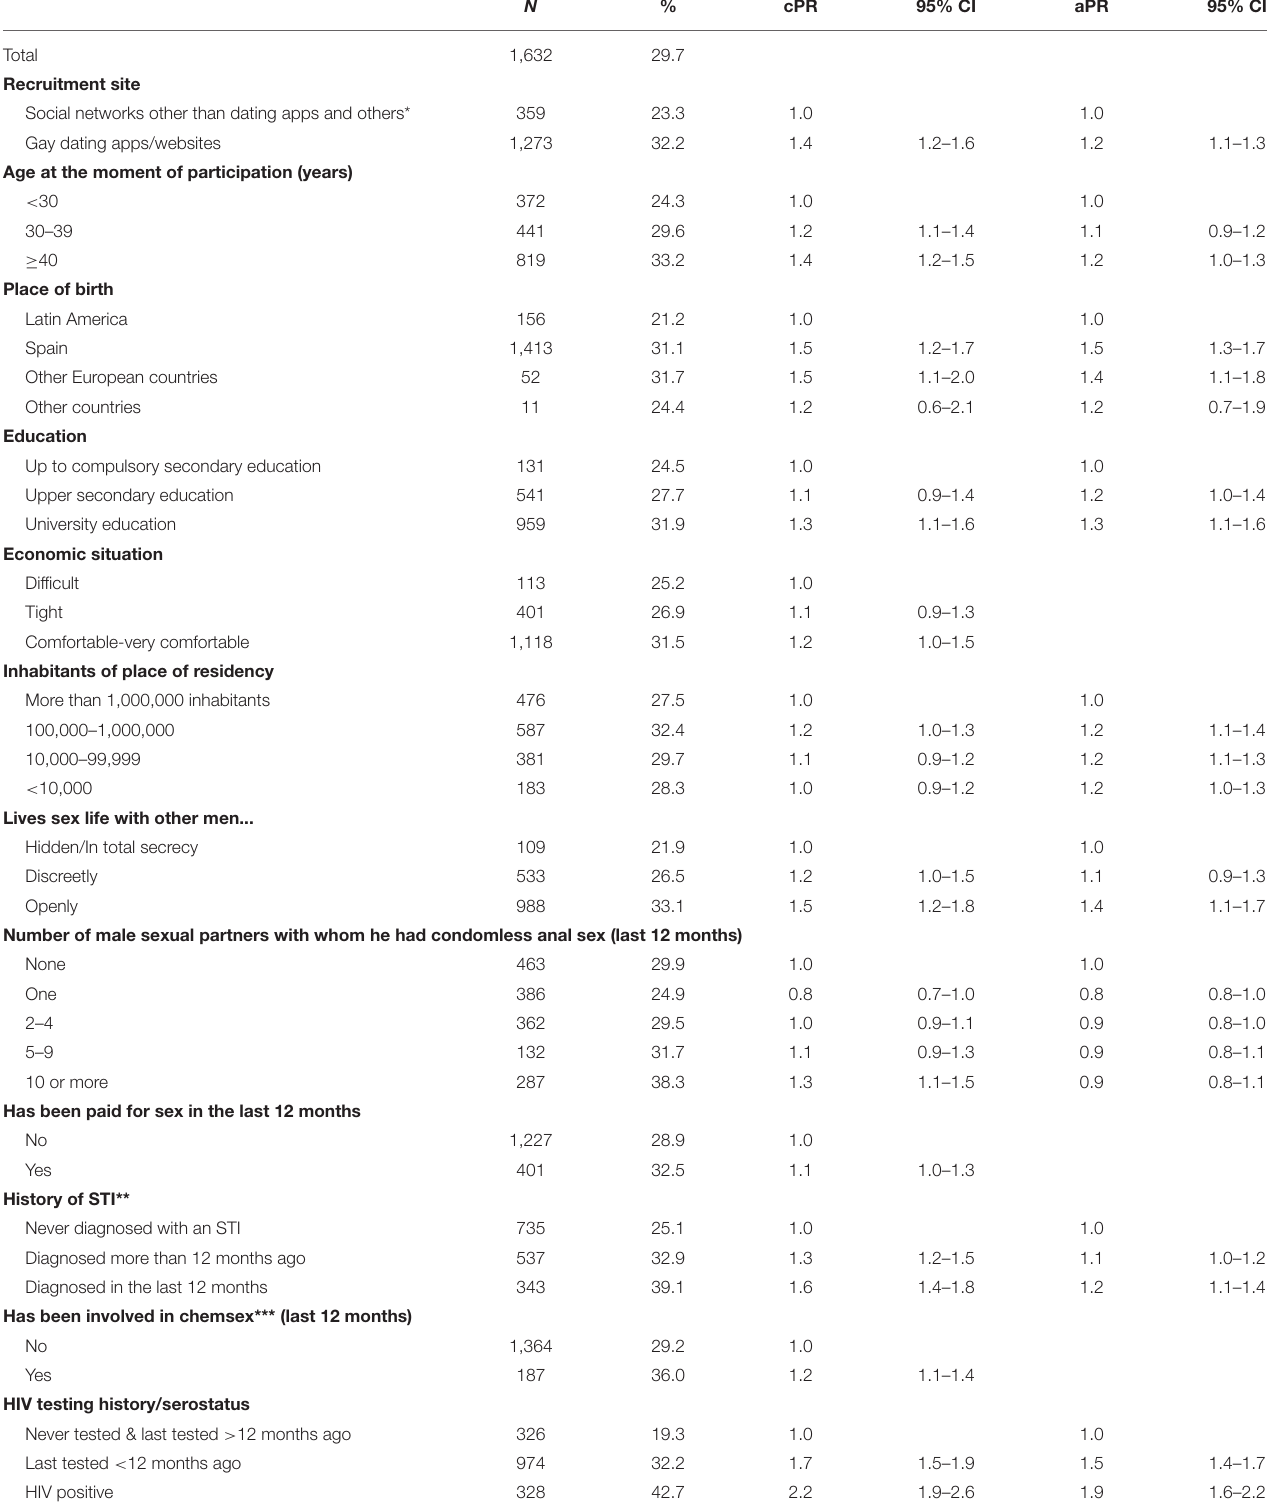
TABLE 2 | Proportion of participants who were aware of the existence of HIV self-testing and associated factors ( N =